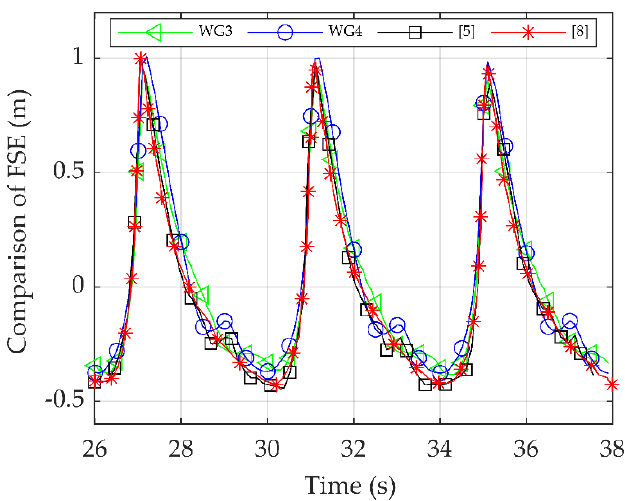
Figure 6. Comparison of the free surface elevation at WG3 and WG4 and the results of [5,8].